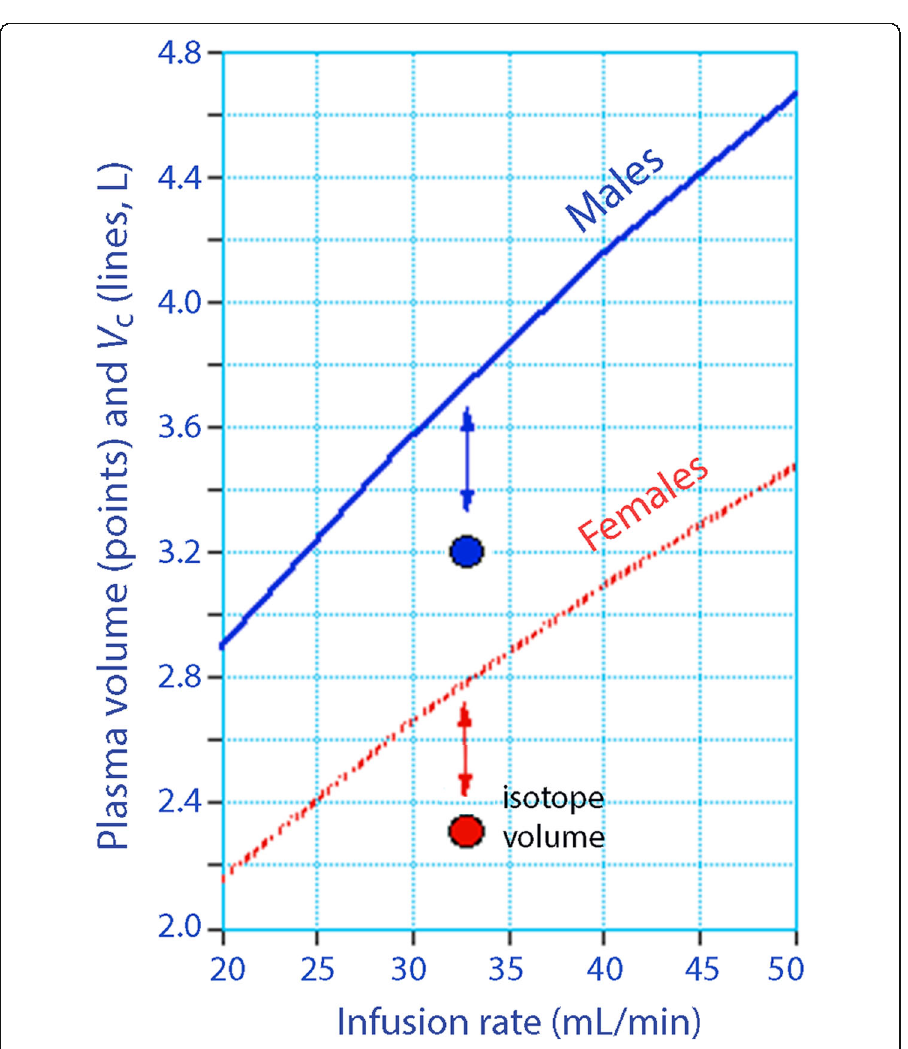
Fig. 3 Central fluid space volume V c for different infusion rates when the body weight is fixed to the mean for males and females (lines). The plasma volume is given as the mean of three published isotope studies using the gender, body weight, and height for each volunteer in the volume kinetic study (circles). The distance indicated by arrows is the water volume in the endothelial glycocalyx